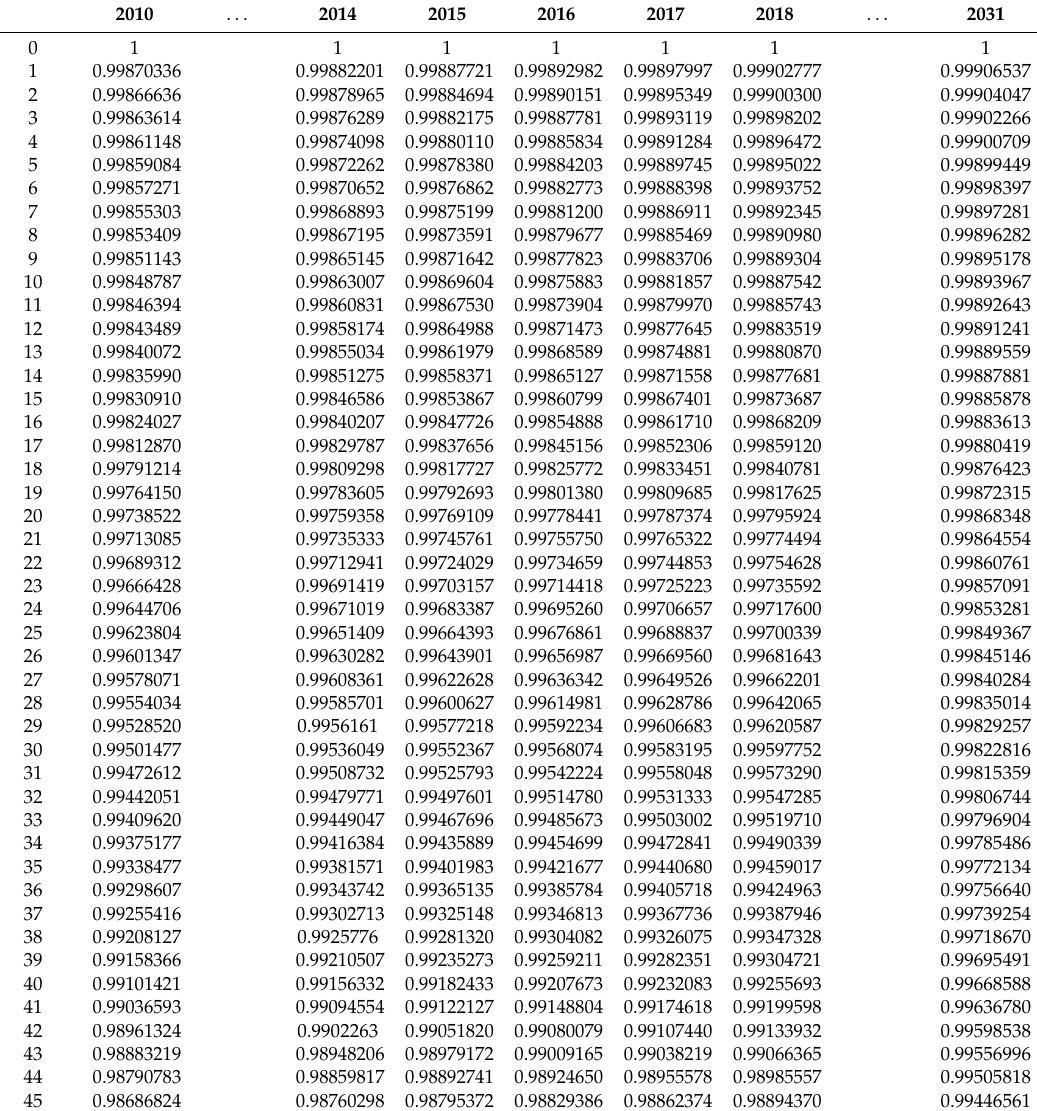
Table A2. Survival probability forecasting p x , U.K.